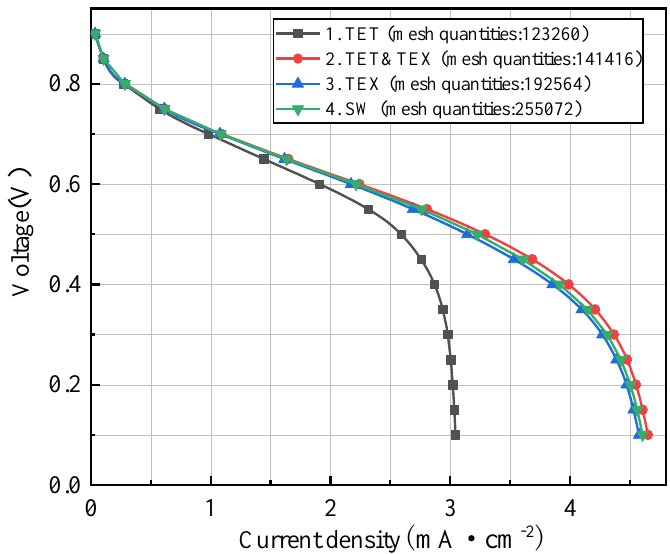
Figure 3. Polarization curves under four different meshing methods.